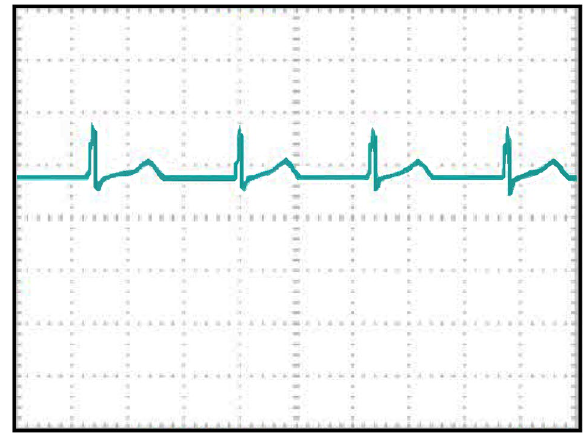
Fig. 16 ECG signal after low pass